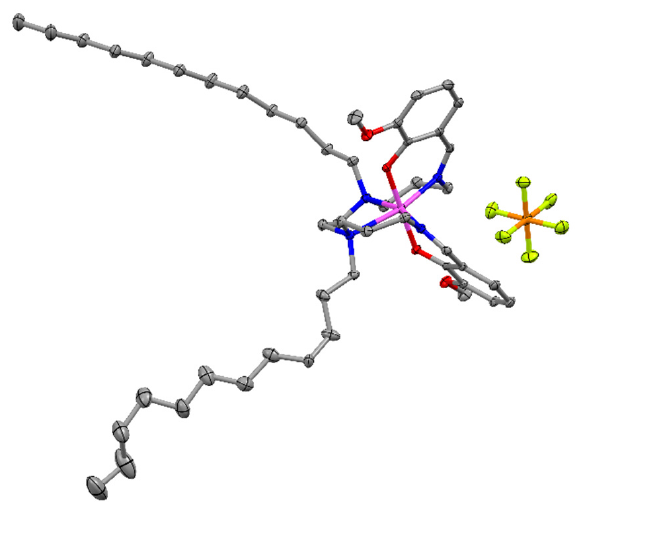
Figure 6. Asymmetric unit of complex ( 6 ), [Mn(4,6-diOMe-sal 2 323-C 6 )](BF 4 ) 0.8 (ClO 4 ) 0.2 · 2CH 3 OH ( a ); and the structural overlap of the cationic species, [Mn(4,6-diOMe-sal 2 323)] + , of complex ( 1 ) [Mn(4,6-diOMe-sal 2 323)]ClO 4 · 0.5H 2 O, (orange), and complex ( 6 ) [Mn(4,6-diOMe-sal 2 323-C 6 )](BF 4 ) 0.8 (ClO 4 ) 0.2 · 2CH 3 OH (turquoise) ( b ). Data collected at 100 K, interstitial solvent molecules, minor anionic component and hydrogen atoms omitted for clarity.